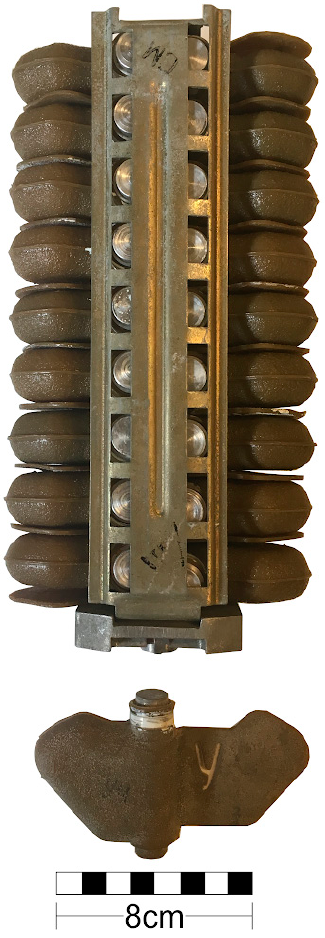
Figure 1. The lightweight 75 g PFM-1 plastic landmine ( bottom ) and the loaded 18-mine aluminum KSF cassete ( top ).